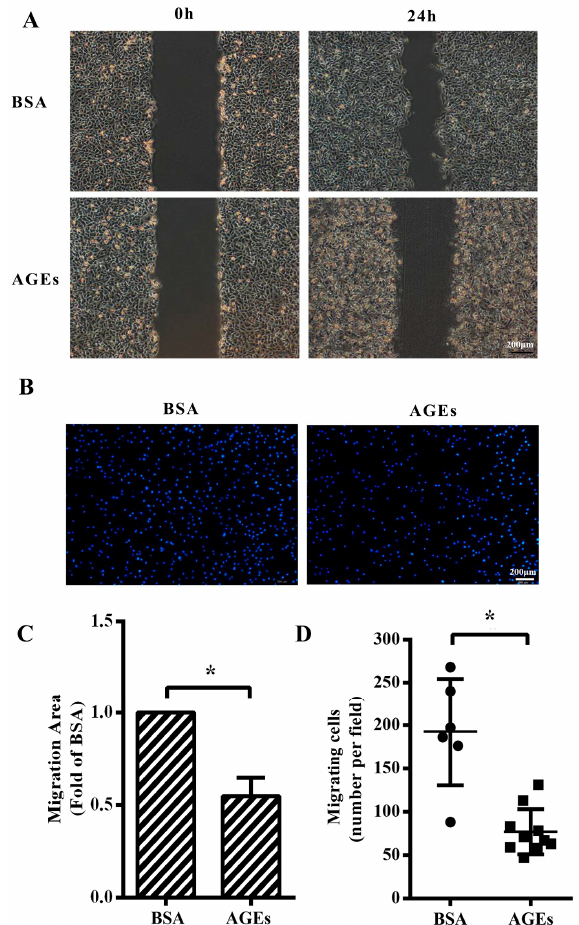
Figure 2. AGEs inhibited the migration of HUVECs. Cells were treated with 100 µg/mL AGEs or 10 µg/mL BSA as control, and incubated with serum-free Dulbecco’s modified Eagle medium (DMEM) for 24 h to inhibit cell proliferation. ( A ) Cell migration was detected by wound-healing assay; ( B ) Migrating cells were detected by Hoechst 33342 staining in the transwell assay. Blue dots represented nuclei; ( C ) Migration area in wound healing assay was quantified using Image J 1.47. Three microscopic fields were randomly selected; ( D ) Migrating cells in transwell assay were calculated using Image J 1.47. Three microscopic fields were randomly selected. All data were obtained from reproducible experiments ( n = 3). * p < 0.05 vs. BSA group.